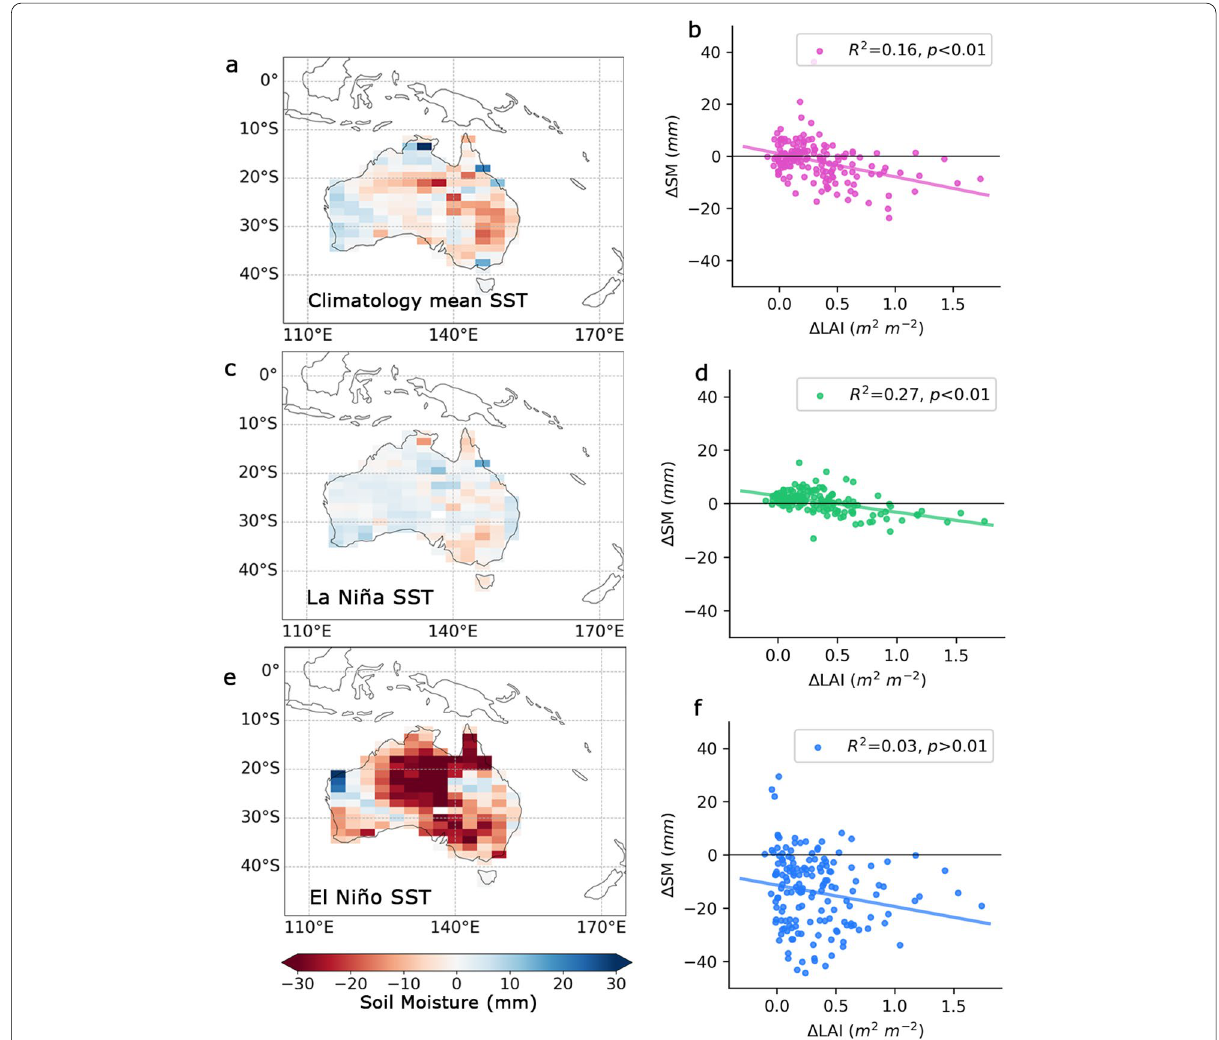
Fig. 3 The patterns of soil moisture in response to the greening under different sea surface temperatures (SSTs). Spatial patterns of changes in soil moisture under three SST model forcings: a climatology mean SST; c La Niña SST; and e El Niño SST. To test the relationships of spatial patterns between greening and the resulting soil moisture changes, sensitivity analysis through linear regression is applied. The sensitivity of soil moisture changes ΔSM to greening indicated by ΔLAI is computed as (cid:31) SM including a total of 163 pixels within Australia for each variable. The results are presented as the corresponding scatter plots of b , d , f under the climatology mean SST, La Niña SST, and El Niño SST,